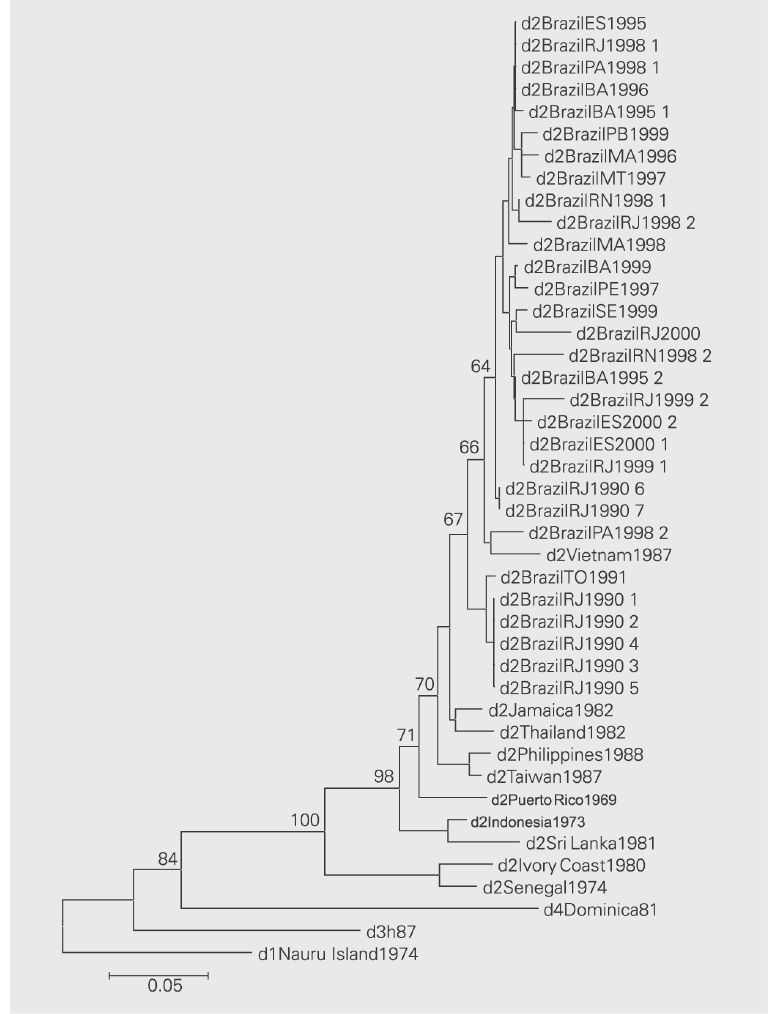
Figure 2. Phylogenetic relationships among dengue-2 (DEN-2) viruses. Phylogenetic tree generated by using neighbor-joining analysis of nucleotide sequences from the E/NS1 junction of 40 strains of DEN-2 and representatives of serotypes 1, 3 and 4. Viruses are listed by strain abbreviation for state and year of isolation (see Table 1). Horizontal branch lengths are drawn to scale. Bootstrap values (500 replicates) are shown for some key nodes that connect the genotypic groups of